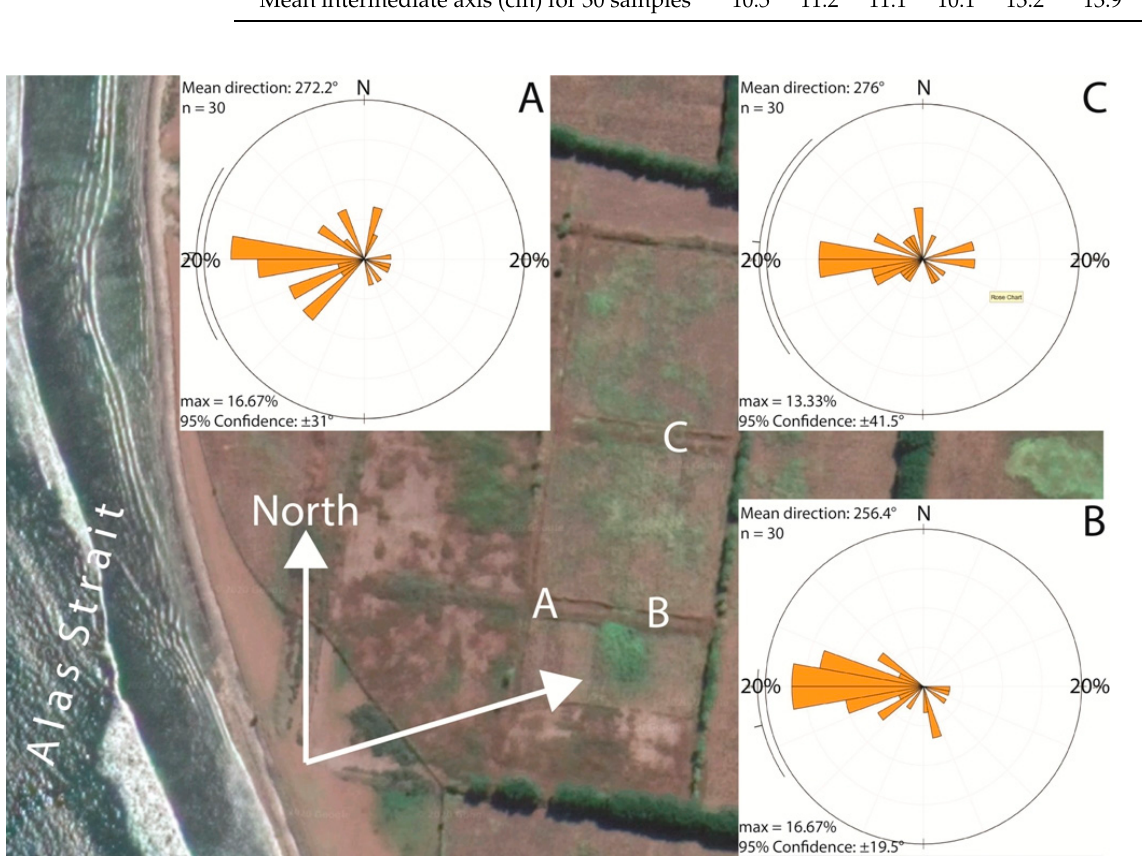
Figure 8. Imbrication measurements evidence for coarse material in abandoned fishponds in Kiantar Village.